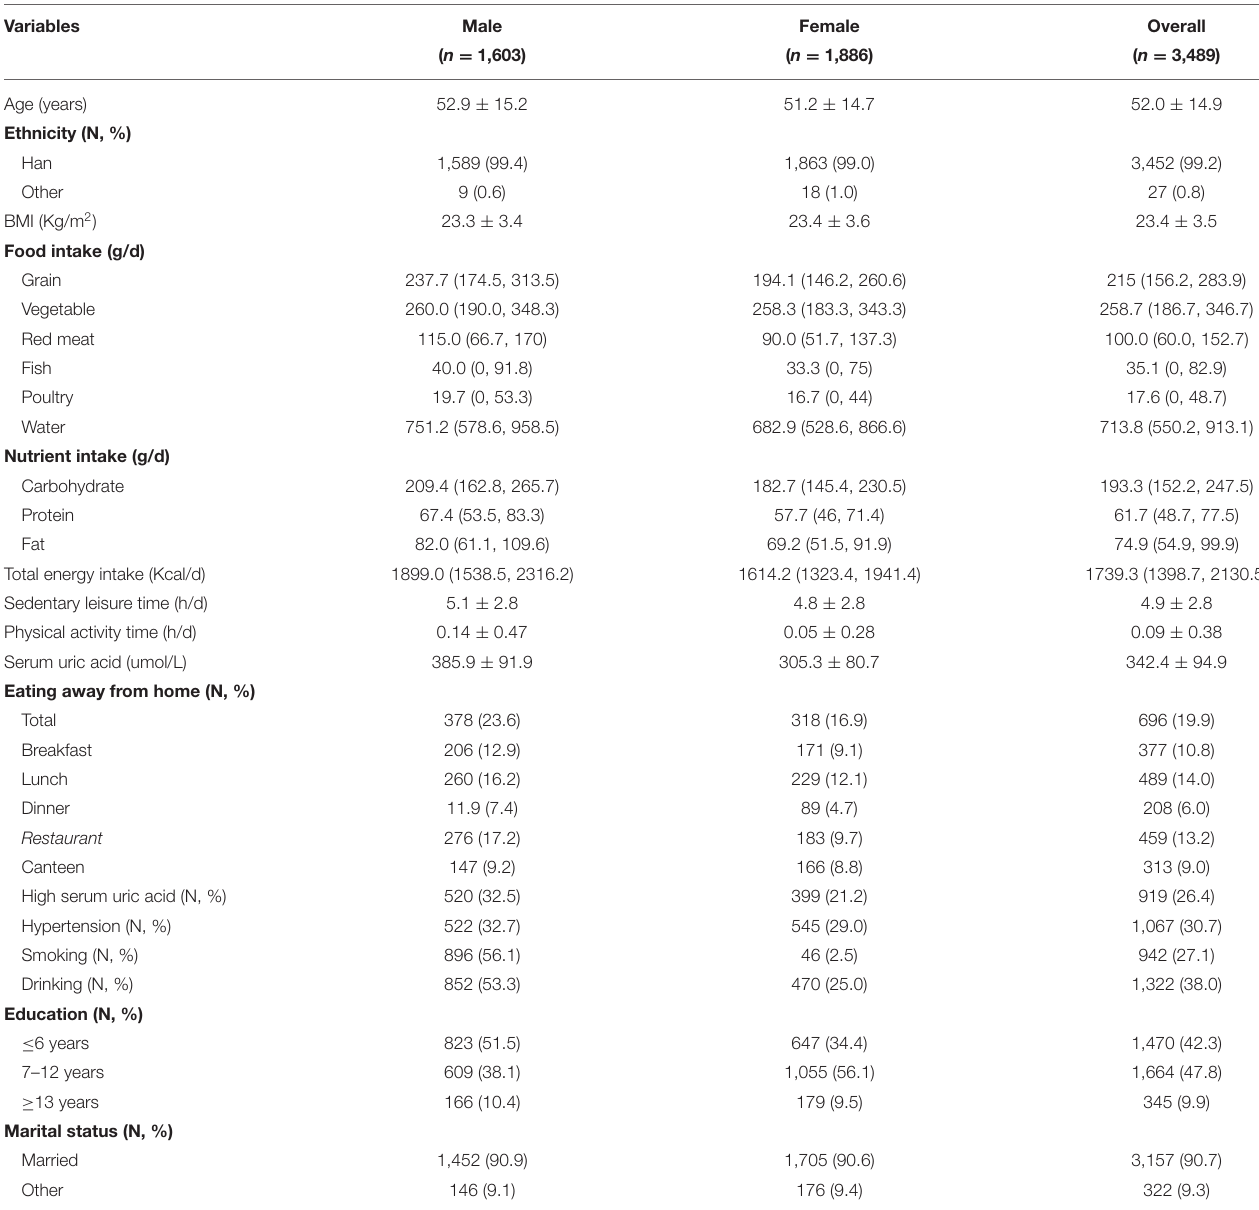
TABLE 1 | Characteristic of eligible